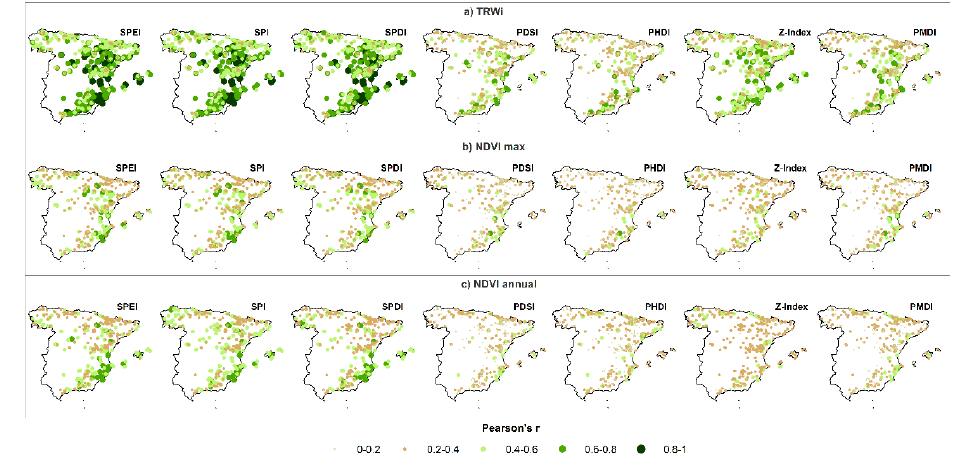
Figure 3. Spatial distribution of the maximum Pearson correlation coefficients computed between the seven drought indices and ring-width indices TRWi ( a ), NDVI max ( b ), and integrated annual NDVI ( c ).